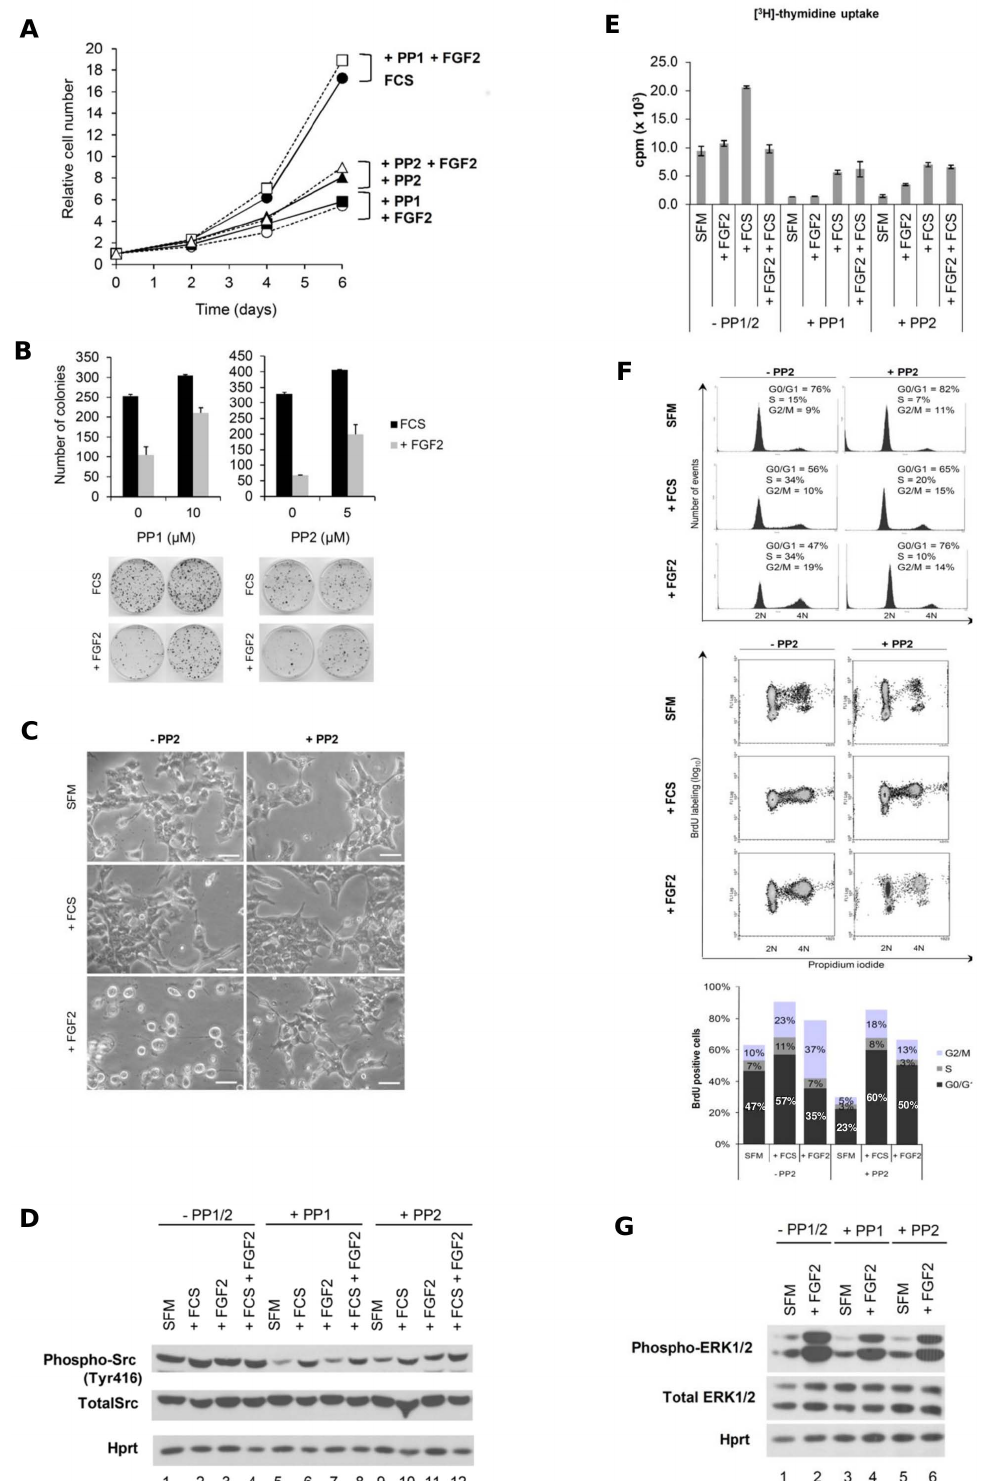
Figure 6. Src activation is necessary for FGF2’s cytostatic mechanisms. ( A ) Growth curves with FGF2 (10 ng/mL) and PP1 or PP2 (5 m M) added 1 hour before FGF2 (10 4 cells/cm 2 were plated). ( B ) Clonogenic assays of Y1 cells treated with FGF2 and/or PP1 (10 m M) or PP2 (5 m M) (added 30 minutes before FGF2) for 24 hours. Insets on the bottom show one representative clonogenic assay in the indicated conditions. Values are mean 6 s.e.m. (n=3). ( C ) Microphotographs for morphological analysis of Y1 cells under FCS or FGF2 stimulation for 48 hours, in the presence, where indicated, of PP2 (10 m M). ( D ) Y1 cells were synchronized in G0/G1 by serum starvation and stimulated with FCS (10%) and/or FGF2 (10 ng/mL) for 30 minutes in the presence of PP1 or PP2 (10 m M). Data are representative of four independent experiments. Phospho-Src (phosphorylated at Tyr416) and total Src were analyzed by immunoblot. Hprt was used as a loading control. ( E ) G0/G1-arrested Y1 cells were stimulated with FCS and/or FGF2 for